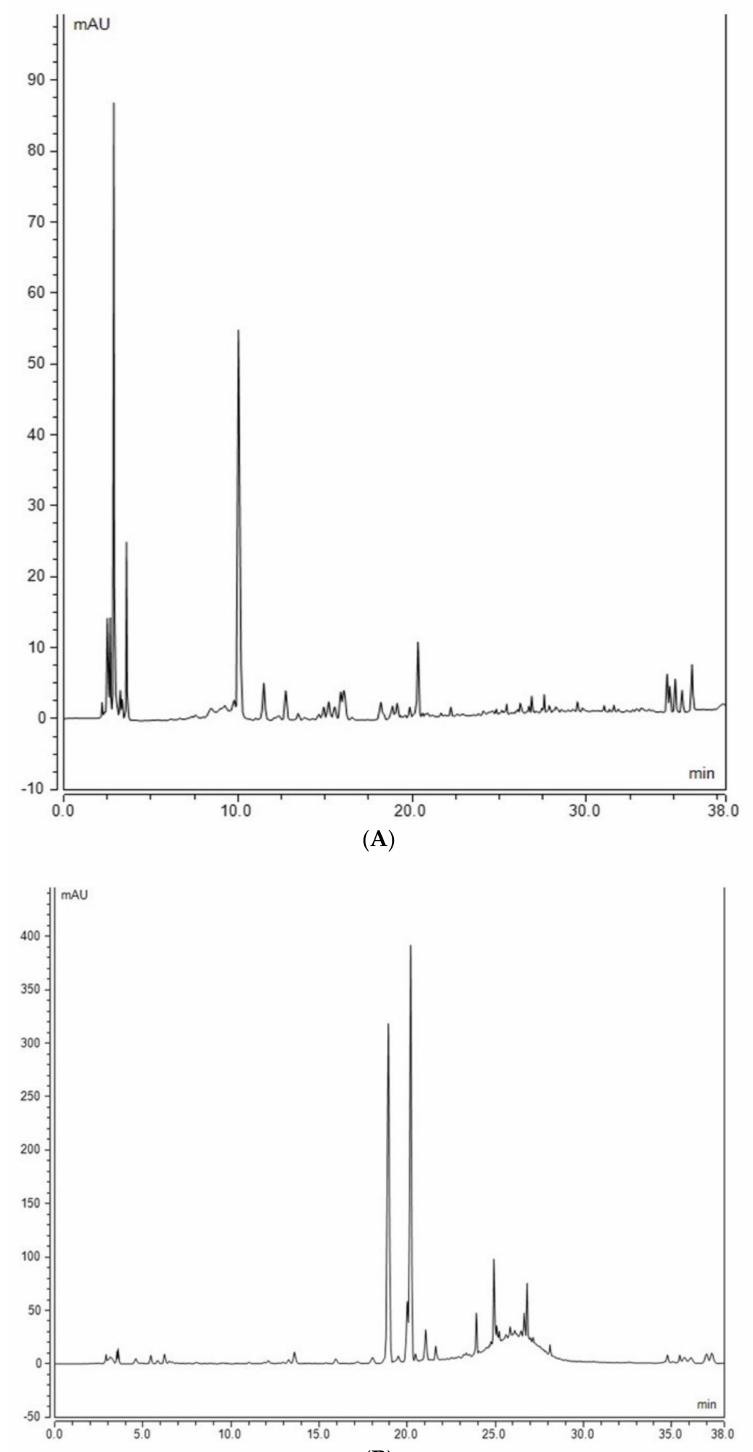
Figure 3. HPLC chromatograms of free and bound compounds in the extracts of elite breeding Line 5 at 280 nm. ( A ) HPLC chromatogram showing the simultaneous analysis of ascorbic acid and free phenolics in the extract of elite breeding Line 5. Compounds identified: Rt 2.867, ascorbic acid; Rt 10.023, unknown; Rt 18.873, PCA; Rt 20.327 FA. ( B ) HPLC chromatogram of the bound phenolics identified in the extract of Line 5. Compounds identified: Rt13.273, VAN A; Rt 13.600, CAF; Rt 18.923, PCA; Rt 20.003, SIN; Rt 20.190, FA; Rt 21.047,